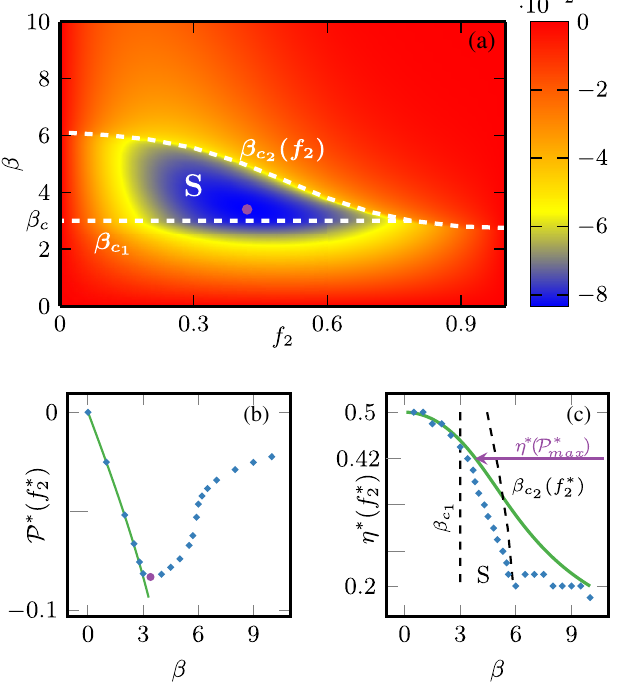
FIG. 12. Depiction of the output power (a) as a function of the output force f 2 and the inverse temperature β . The white dashed lines correspond to the numerically determined critical points as a function of the output force. Hence, the enclosed area defines the synchronization phase S. The global maximum of the output power is indicated by the purple closed circle. In (b), the maximum output power P (cid:3) is optimized with respect to f 2 , and in (c) the associated EMP η (cid:3) ð f (cid:3) 2 Þ is displayed. In (c), the dashed lines specify the critical points and the synchronization phase S. The efficiency at the global maximum power is indicated by the purple arrow. The (semi)analytic solution for β < β (green lines) is overlaid with the numerical data in the lower